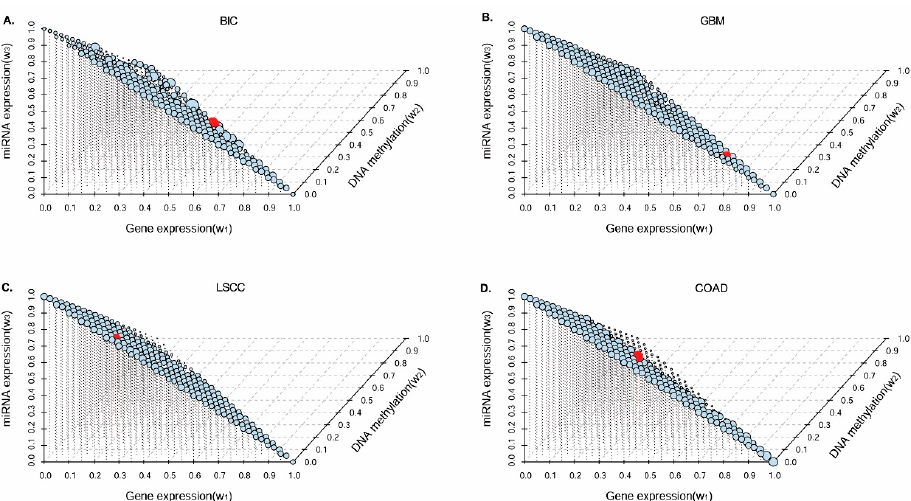
Figure 2. The Cox log-rank p -value distribution in survival analyses of similarity regression fusion (SRF) identified subtypes by using different weight parameters in integration. Gene expression, DNA methylation, and miRNA expression data were used in this study. The size of dot determined by − log( p -value). We selected weight parameters with the smallest p -value in each cancer data (red dot) in our study. ( A – D ) Cox log-rank p -value distribution using differently integrative weights in BIC, GBM, LSCC, and COAD cancer datasets, respectively.